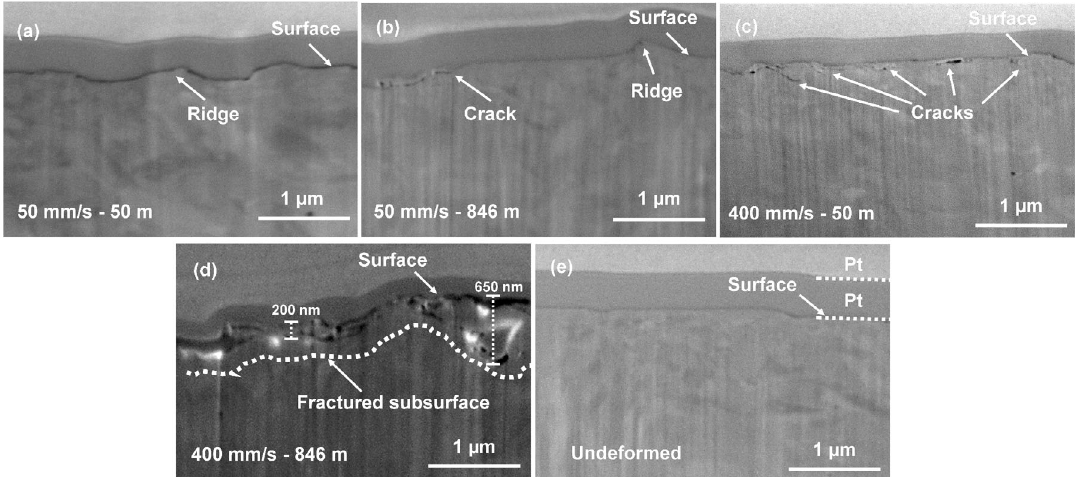
Fig. 7 Cross-sectional SEM images of pins: (a) sliding 50 m at 50 mm/s; (b) sliding 846 m at 50 mm/s; (c) sliding 50 m at 400 mm/s; (d) sliding 846 m at 400 mm/s; and (e) undeformed